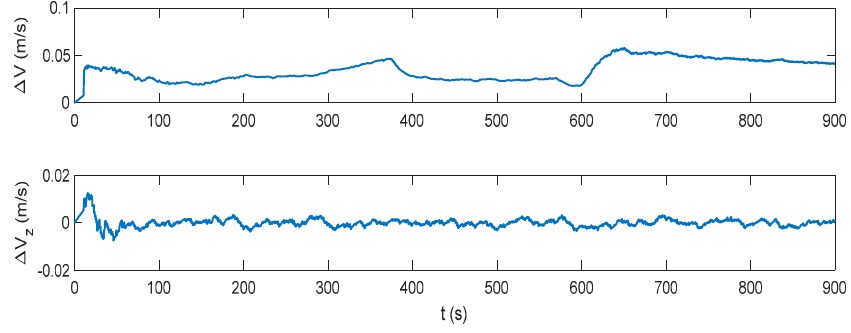
Figure 10. Velocity error of the IMM-aided ZUPT solution.